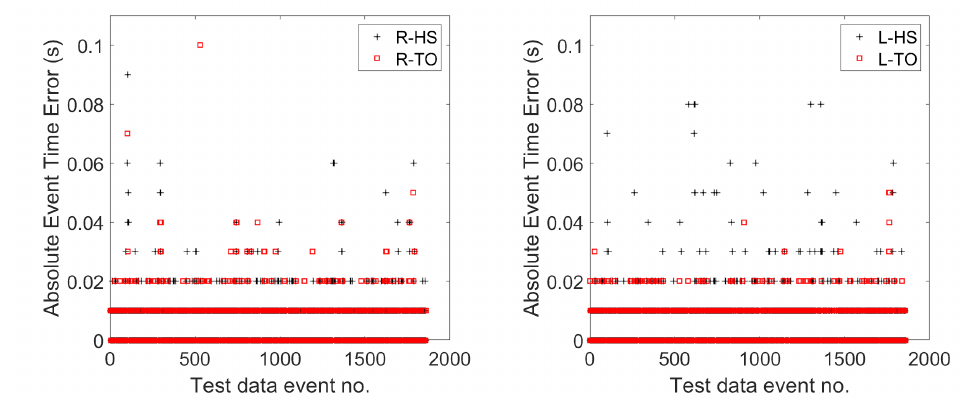
Figure 9. Event prediction errors for right and left, heel-strike, and toe-off events.